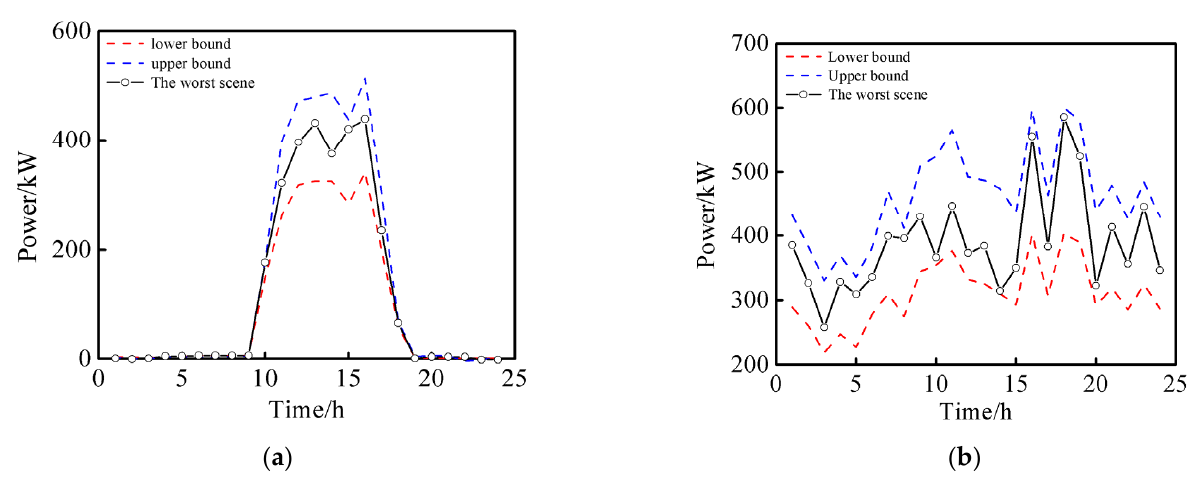
Figure 12. Worst scenario set of Subsystem 3 under Scenario 4. ( a ) Photovoltaic. ( b ) Electric load.